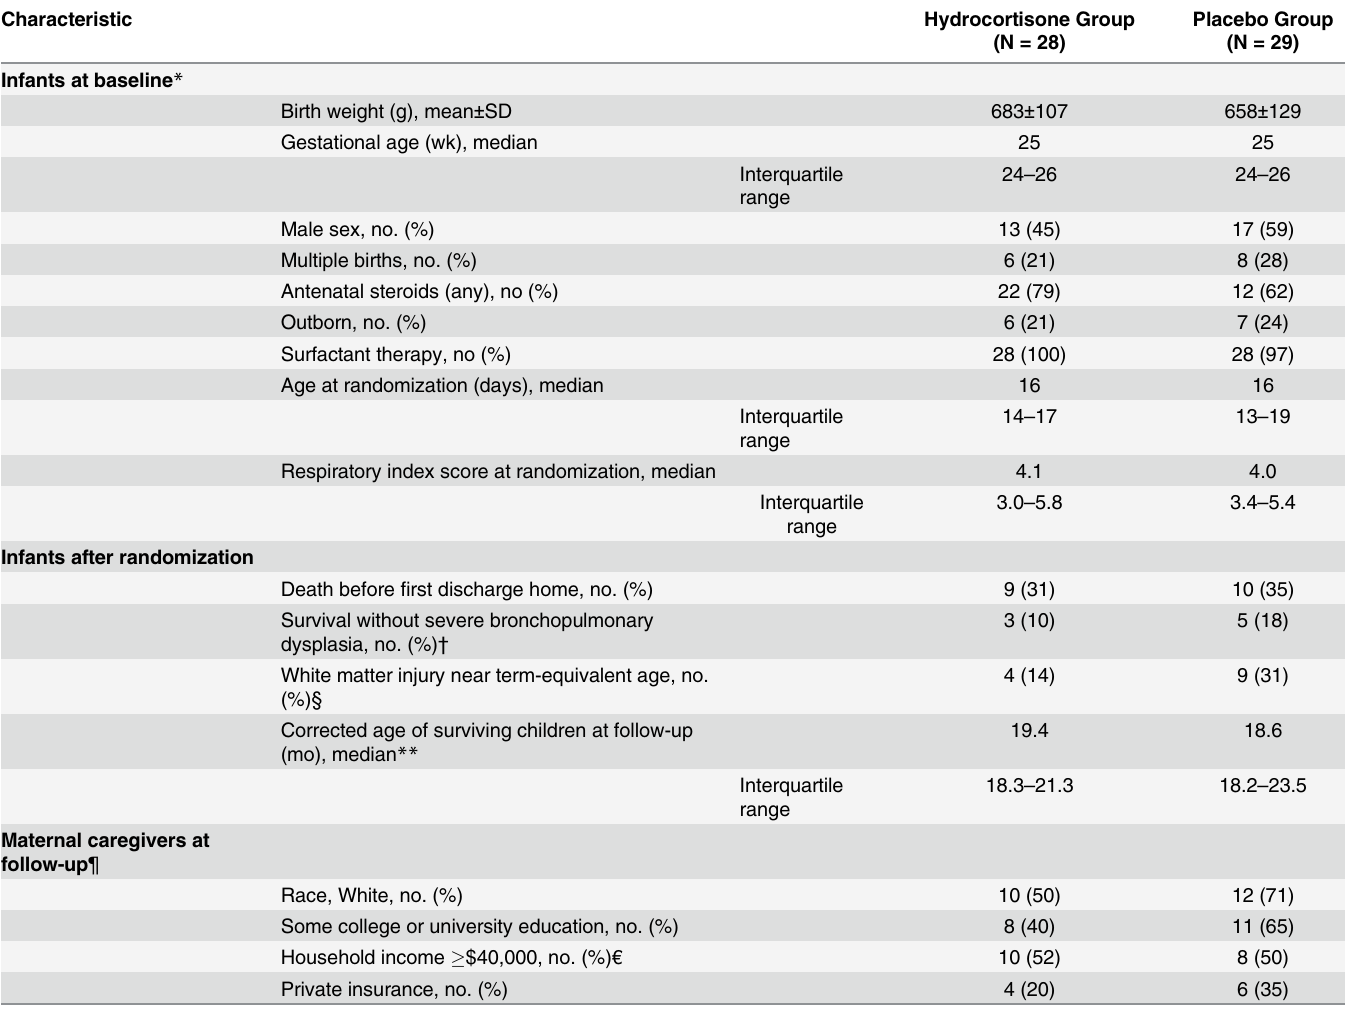
Table 1. Characteristics of the Children and Their